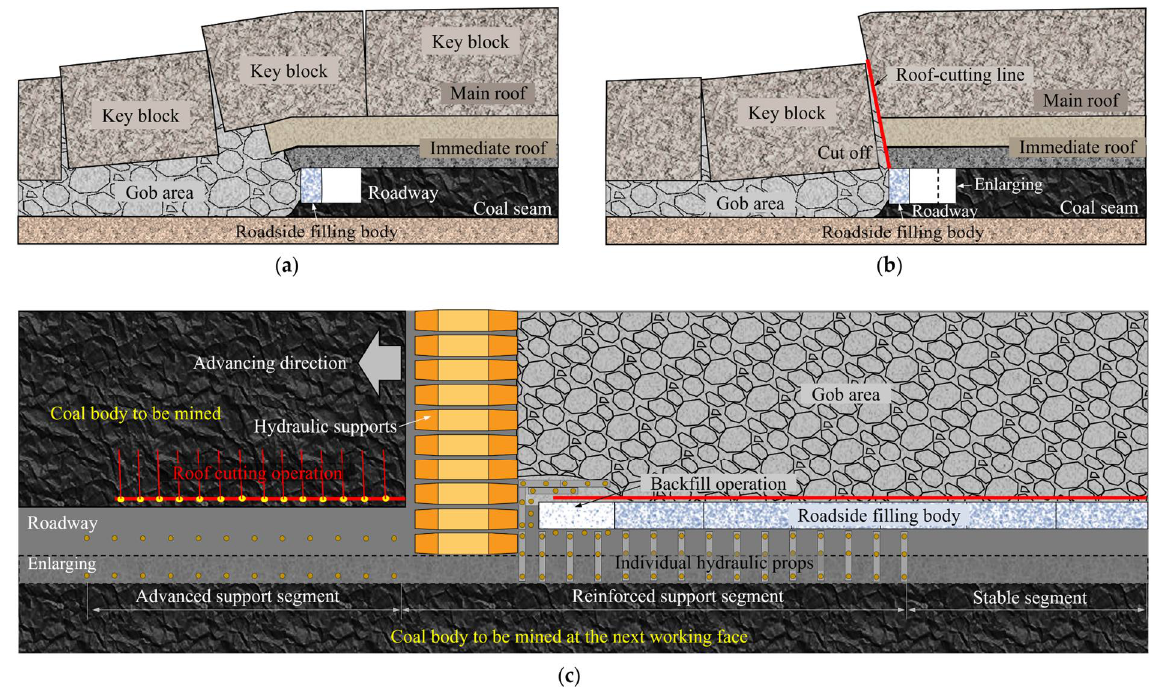
Figure 11. Advance pre-splitting and cutting roof for gob-side entry retaining. ( a ) Gob-side entry retaining with backfill ( b ) Roof cutting operation in advance ( c ) Working methods of roof cutting in advance and gob-side entry retaining with backfill.